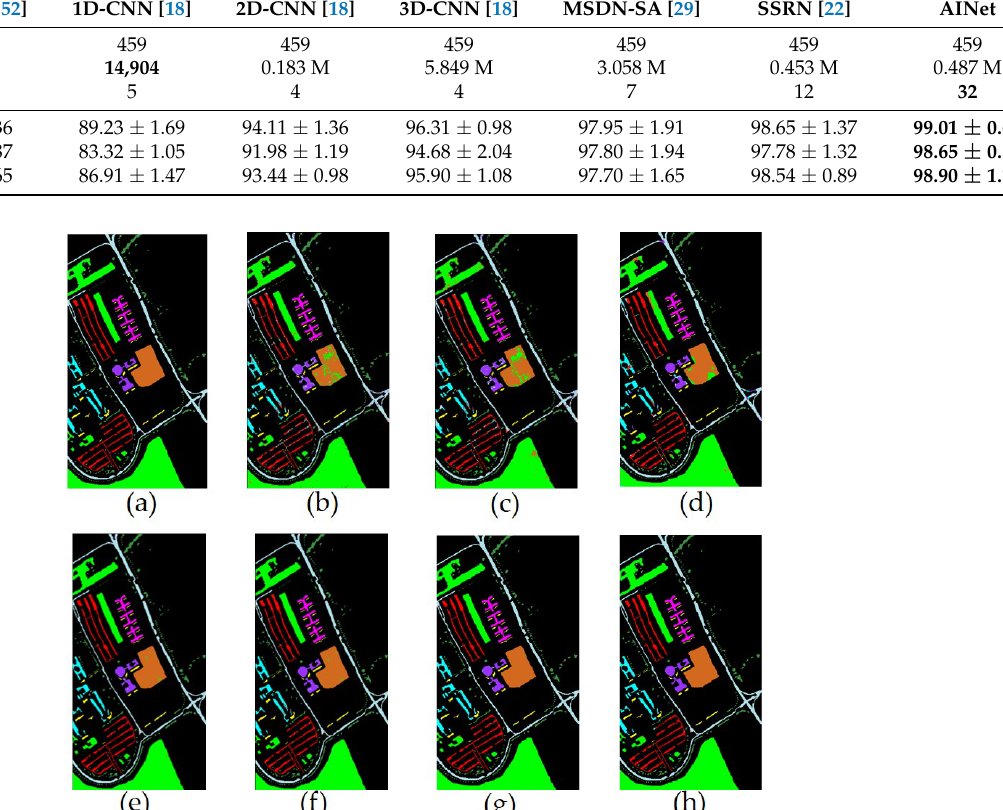
Figure 6. Classification maps for Pavia University dataset. ( a ) Ground-truth map; ( b ) SVM-3DG; ( c ) 1D-CNN; ( d ) 2D-CNN; ( e ) 3D-CNN; ( f ) MSDN-SA; ( g ) SSRN; ( h )